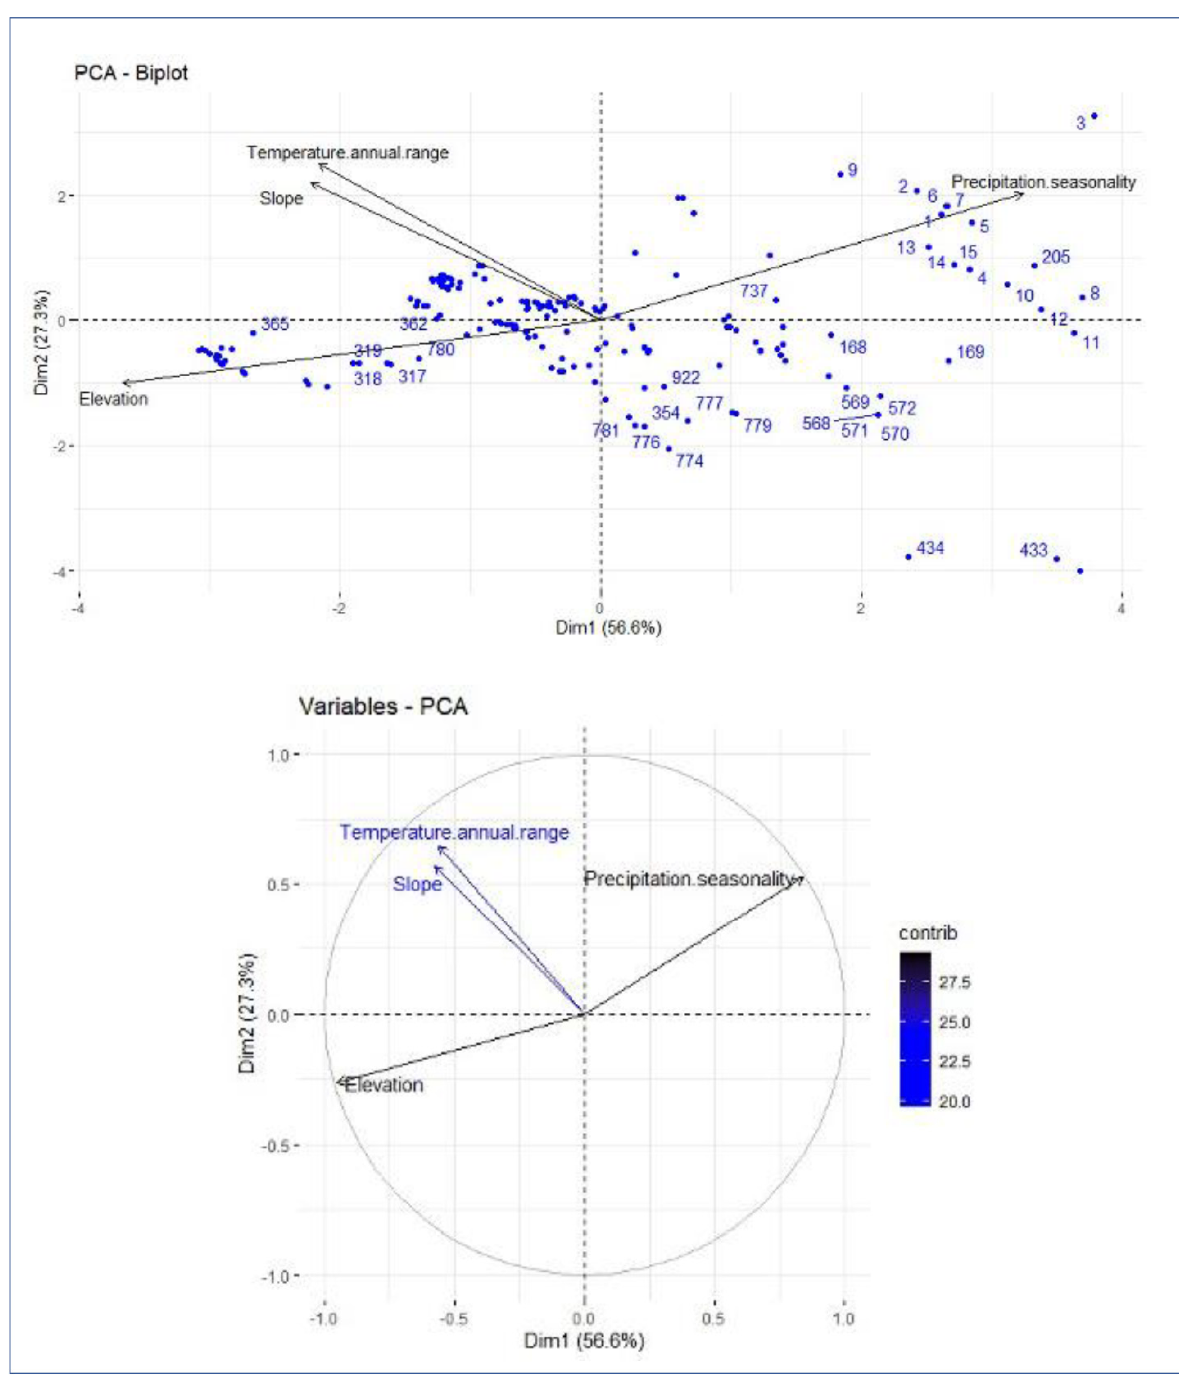
Figure 6. Variable contribution analysis and bi-plot of the annual temperature range, precipitation seasonality, elevation, and slope of Magnolia spp. Above: PCA—Biplot; below: Variables—PCA. The spatial distribution prediction map for Magnolia spp. is presented in Figure 7.